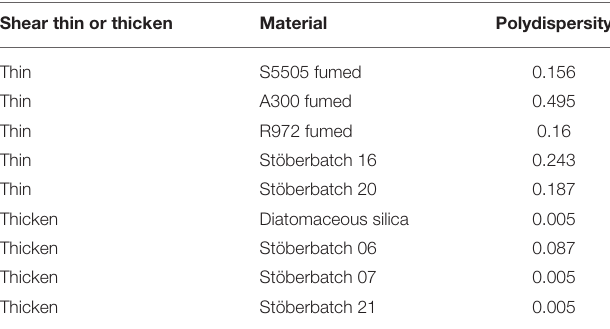
TABLE 1 | Particle dispersity as measured with light